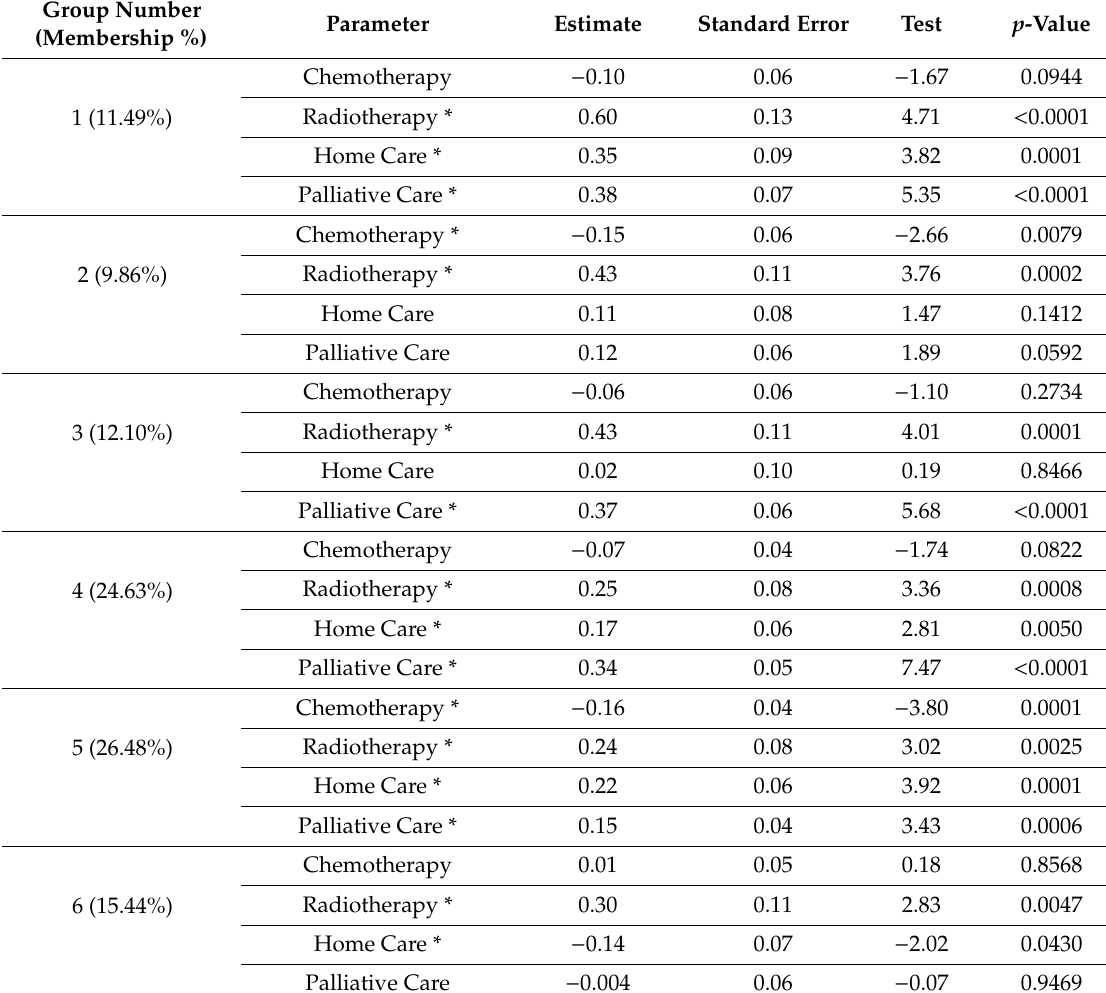
Table 4. Parameter estimates, errors, tests, and p -values for adjusted